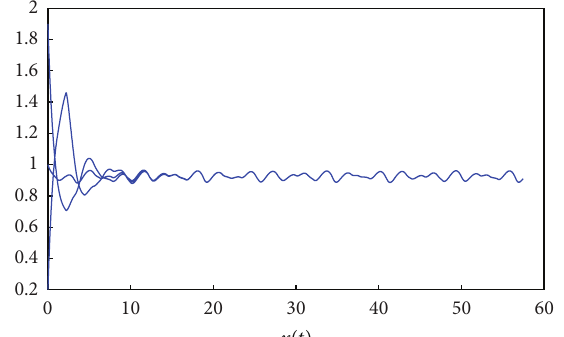
Figure 1: Numerical solution 𝑥(𝑡) of (63) for initial value 𝜑(𝑡) ≡ 0.2, 1, 1.9